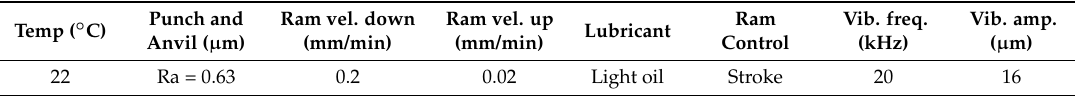
Table 2. Ultrasonic orbital microforming (UOM) process parameters.